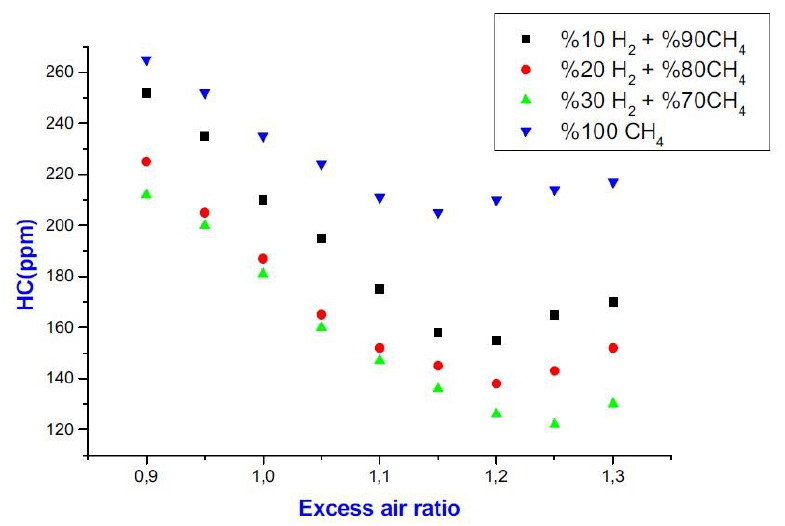
Figure 17. Reducing UHC emissions using hydrogen fuel in gasoline engines [75].